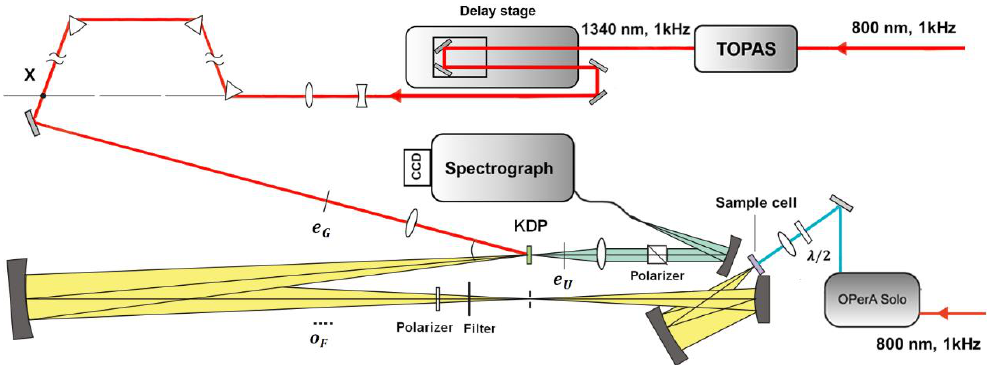
Figure 3. Scheme of fs-resolved broad band fluorescence upconversion